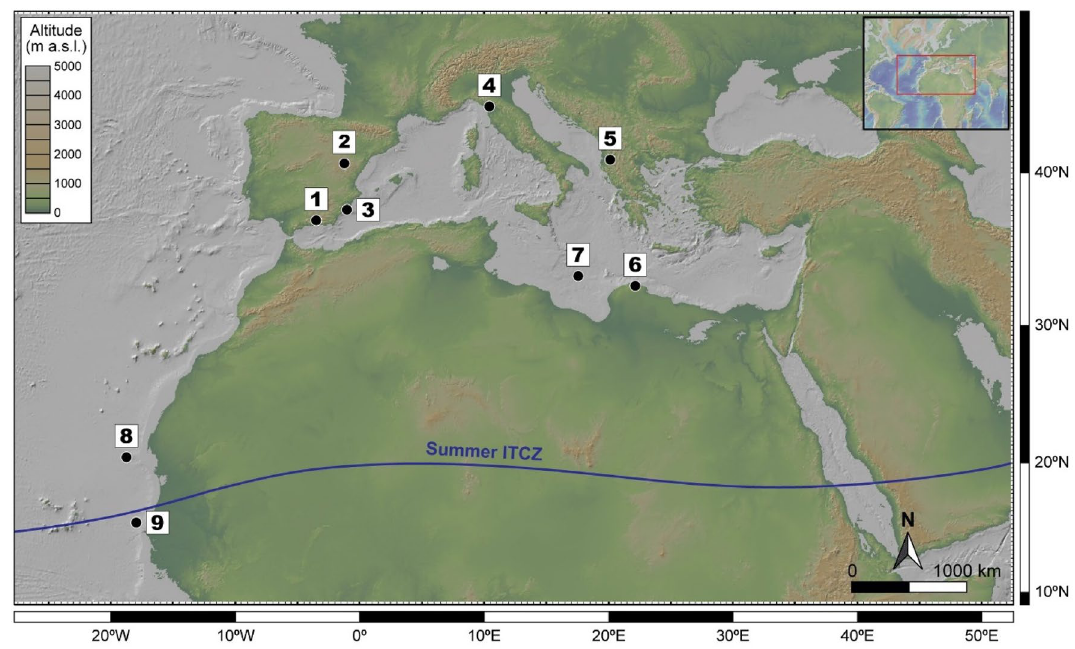
Figure 1. Map showing the paleoclimate records mentioned in this study: (1) Padul (Spain), (2) Villarquemado (Spain) 29,30 , (3) Victoria cave (Spain) 45 , (4) Corchia cave (Italy) 41–44 , (5) Lake Ohrid (Macedonia/Albania) 11 , (6) Susah cave (Libya) 2,46 , (7) 64PE349-8 record (offshore Libya) 47 , (8) GeoB7920-2 record (offshore Mauritania) 58 and (9) GeoB9508-5 record (offshore Senegal) 51 . The present-day position of the summer ITCZ is shown. Map obtained from GeoMapApp (www. geoma papp. org) 95 /CC